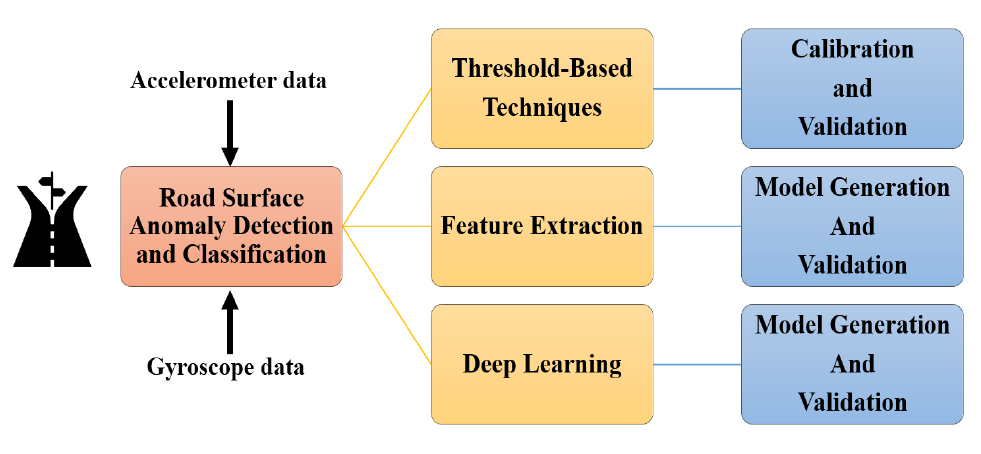
Figure 2. Overview of the approaches used for the detection and classification of road surface anomalies based on vibration-based